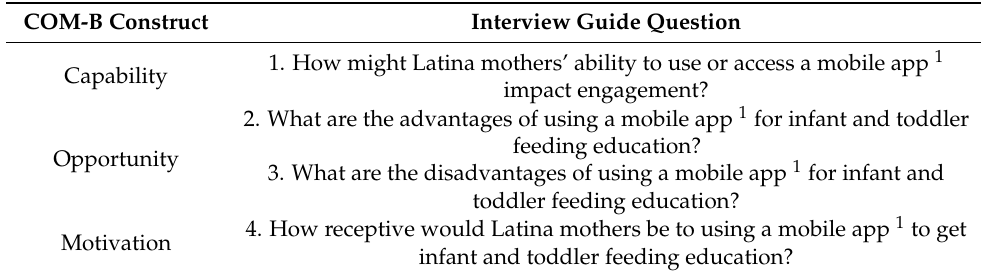
Table 1. Semi-structured interview guide questions with corresponding Capability Opportunity Motivation-Behavior (COM-B) framework